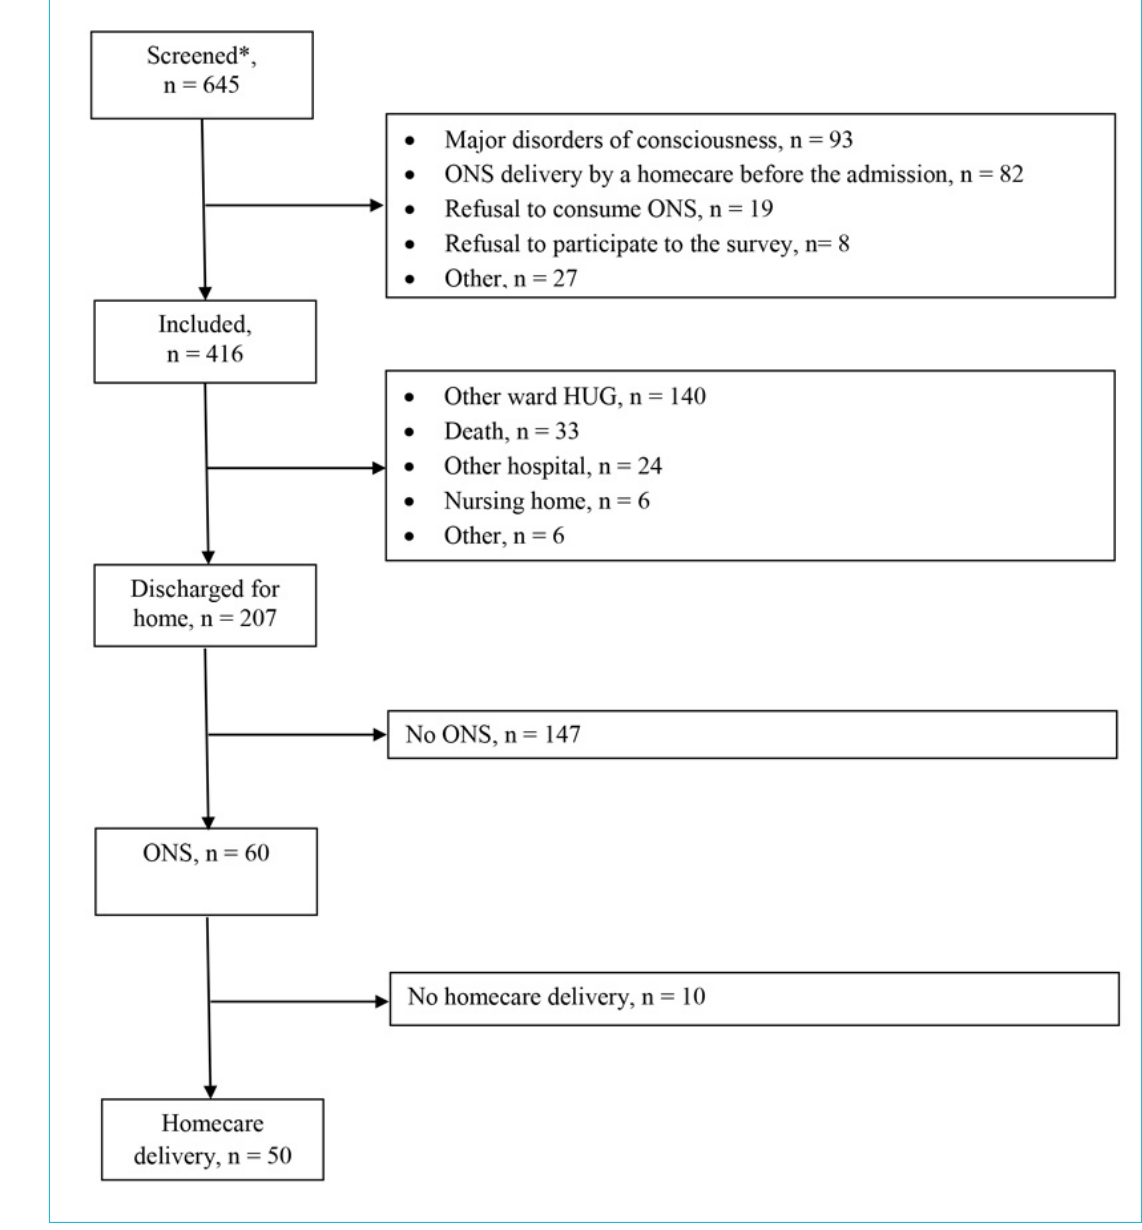
Figure 1: Selection of patients included in the survey.* All adult patients who received ONS for the first time on their meal trays in the screened hospital